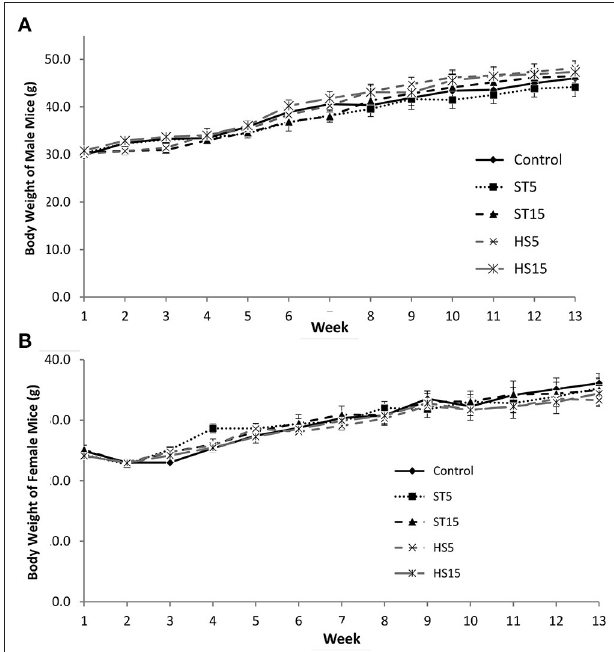
FIGURE 4 | Comparison of weight gain of mice fed either transgenic ‘HoneySweet’ dried fruit, ‘Stanley’ dried fruit or a control diet. (A) Body weight of male ( n = 75), CD-1 mice. (B) Body weight of female ( n = 75), CD-1 mice. No significant differences were observed in body weight across the 90-day study duration. Error bars reflect SE. Control = standard mouse diet; ST5, standard mouse diet with 5% by weight ‘Stanley’ dried plum included; ST15, standard mouse diet with 15% by weight ‘Stanley’ dried plum included; HS5, standard mouse diet with 5% by weight ‘HoneySweet’ dried plum included, and ST15, standard mouse diet with 15% by weight ‘HoneySweet’ dried plum included.